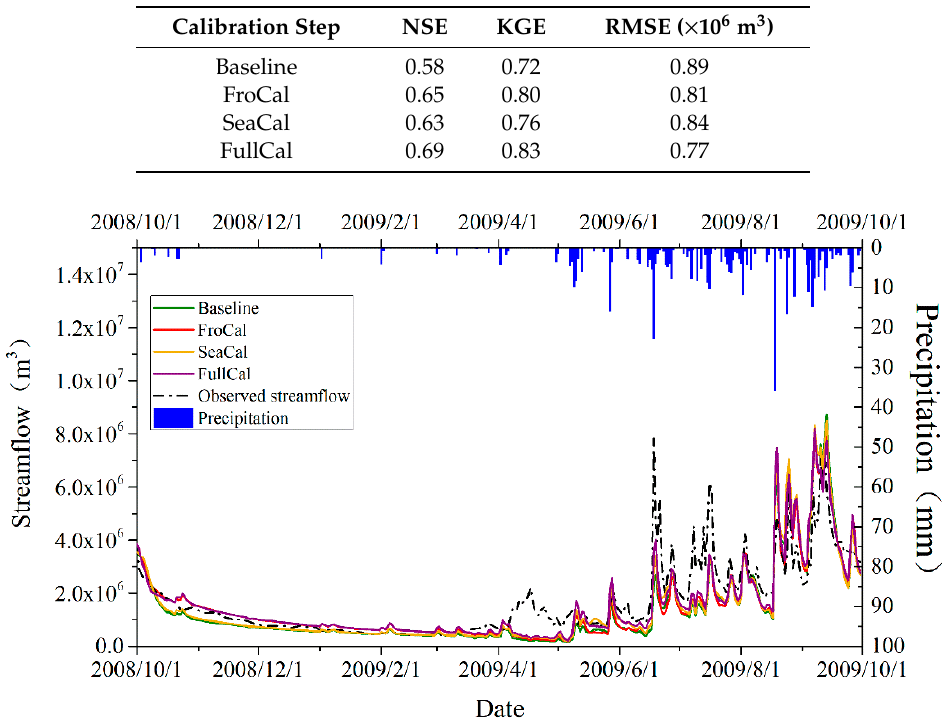
Table 4. The Nash–Sutcli ff e e ffi ciency (NSE), Kling–Gupta e ffi ciency (KGE) and root-mean-square error (RMSE) measured from the simulated and observed daily streamflow with the parameters optimized in each of the four calibration steps.